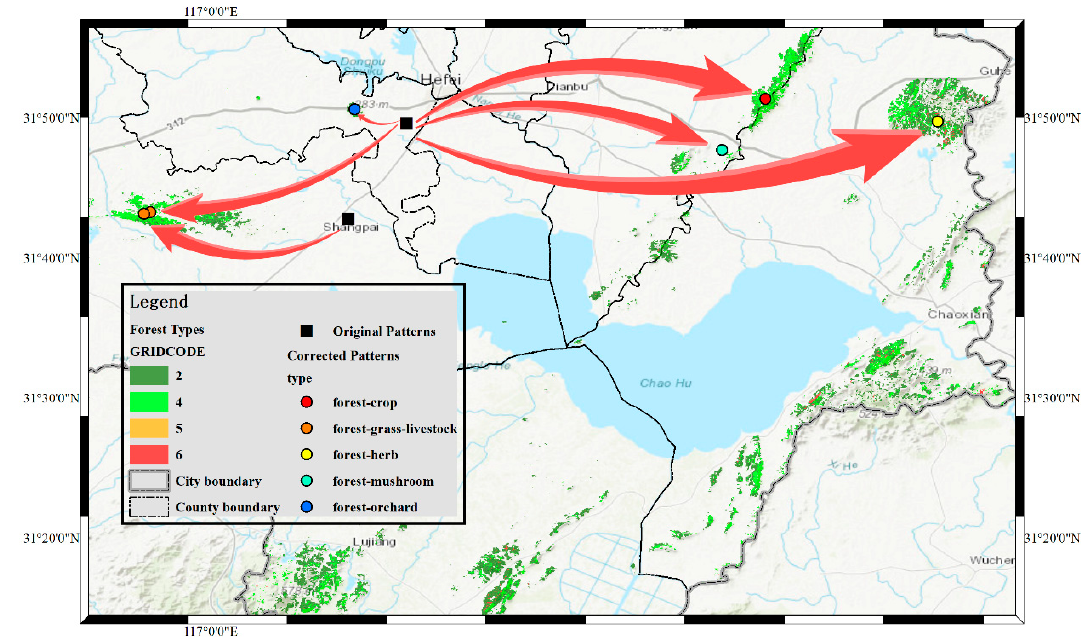
Figure 6. Correction routes of forest ecological patterns in Hefei.